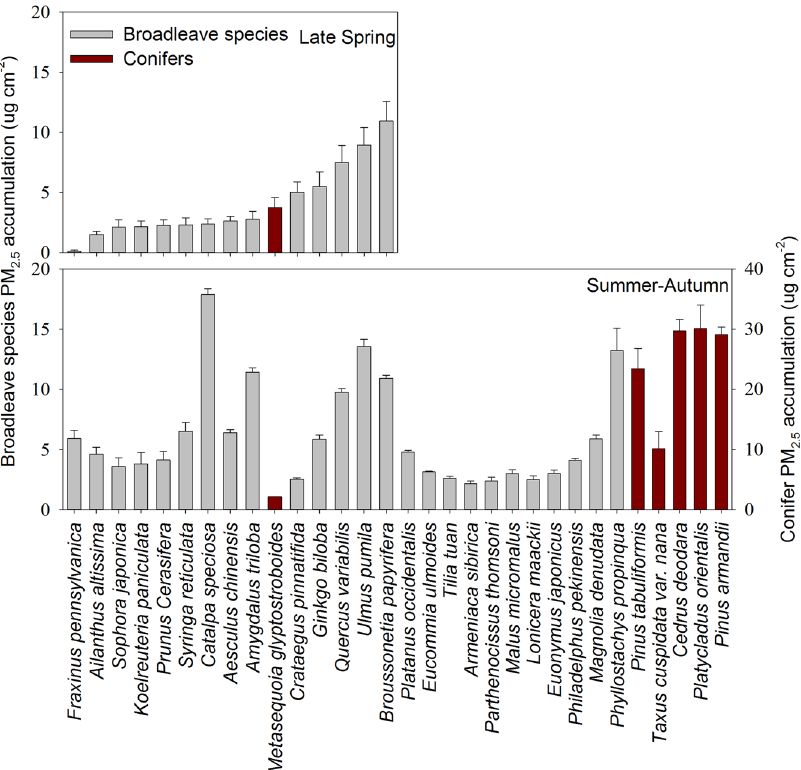
Figure 1. Comparison of foliar accumulation of atmospheric PM 2.5 among by different tree species (coniferous and broadleaved) measured in ( a ) late spring and ( b ) summer through autumn. The within-sample variability of PM 2.5 of each species presented as error bars.